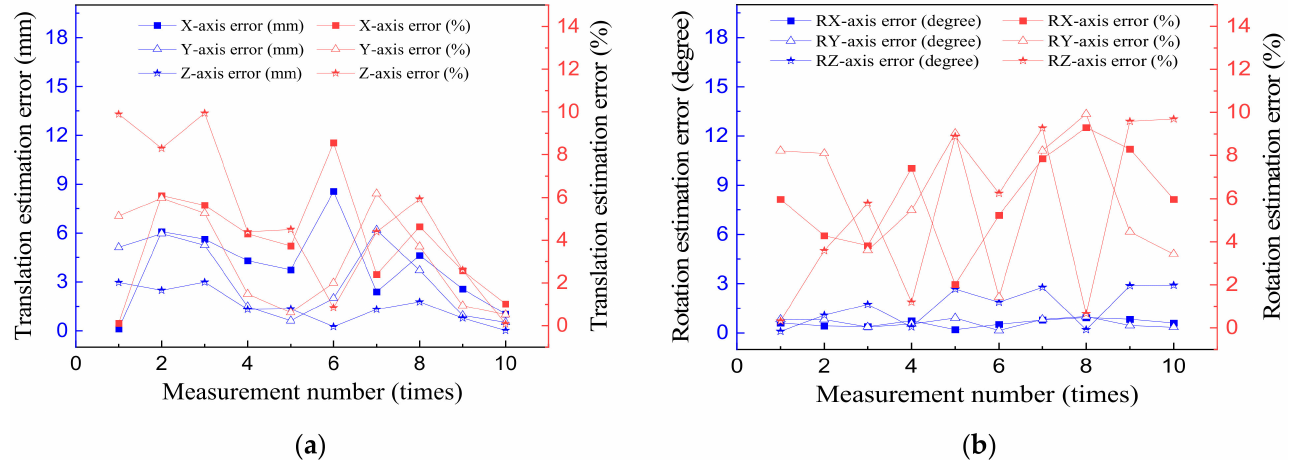
Figure 13. Repetition error and error percentage of the 6-DoF pose estimation system: ( a ) translations of X, Y, and Z axes, and ( b ) rotations of RX, RY, and RZ axes.